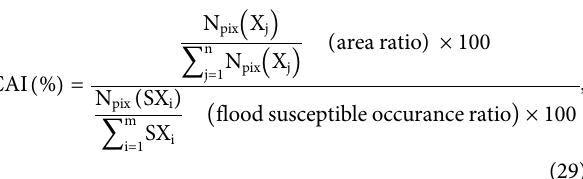
Frontiers in Earth Science |